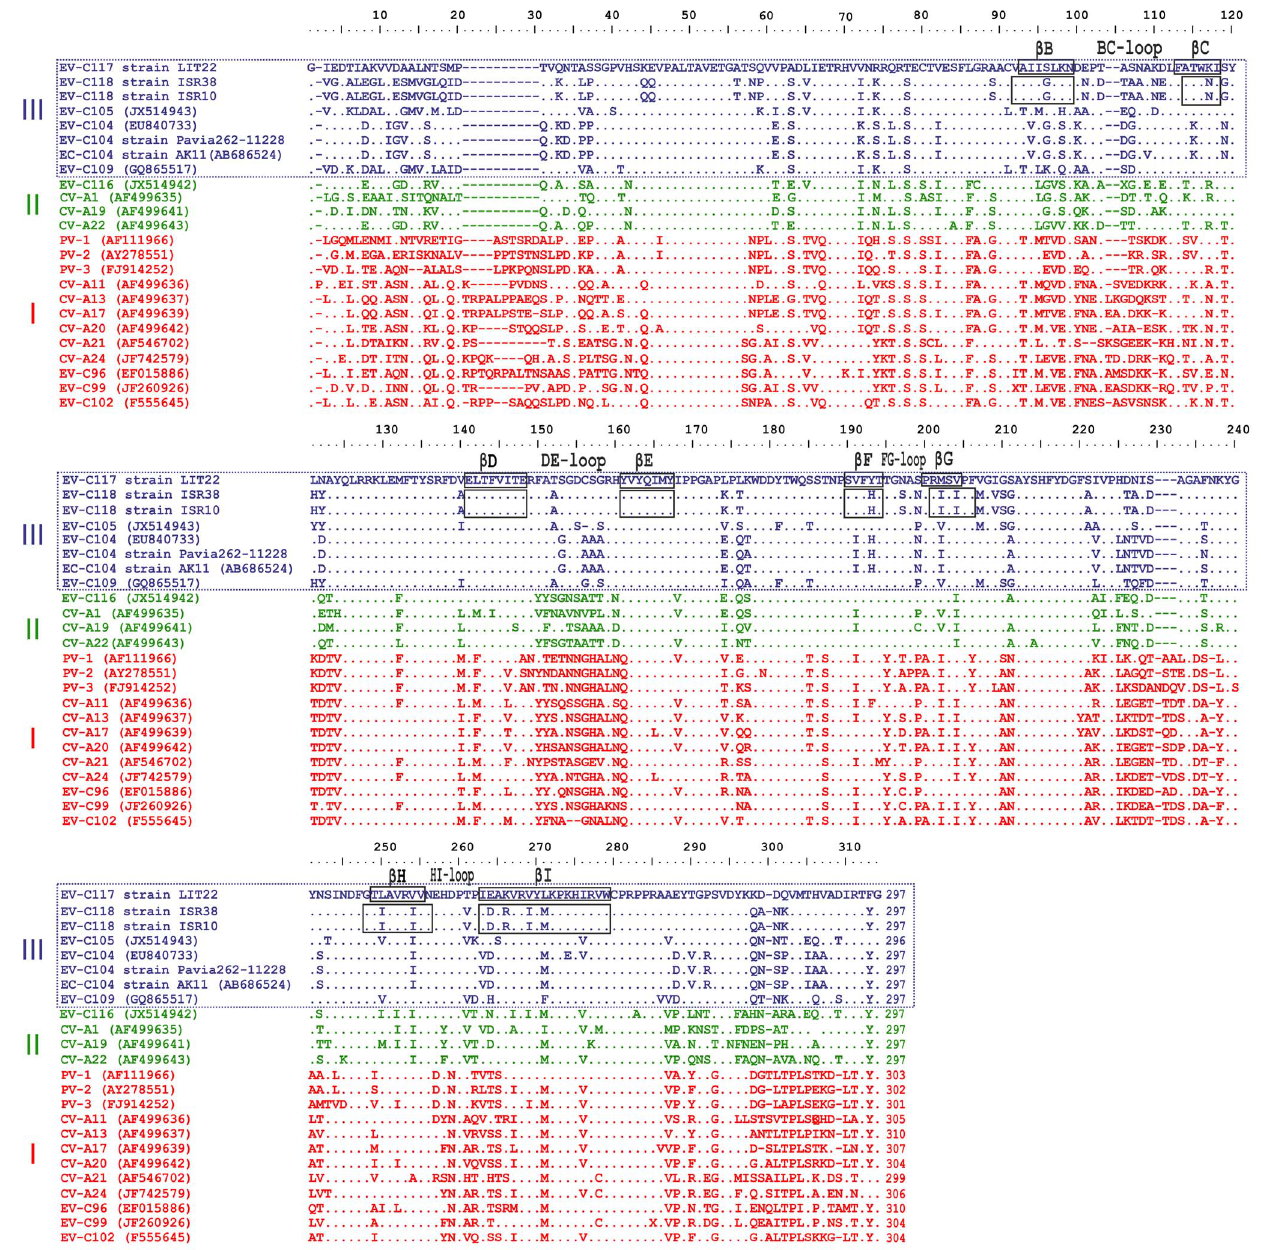
Figure 3. Alignment of the VP1 amino acid sequences of EV-C117, EV-C118 and the HEV strains. The b -sheets are identified by black boxes. The gaps are indicated by a dash (-) and the conserved amino acid residues by a dot